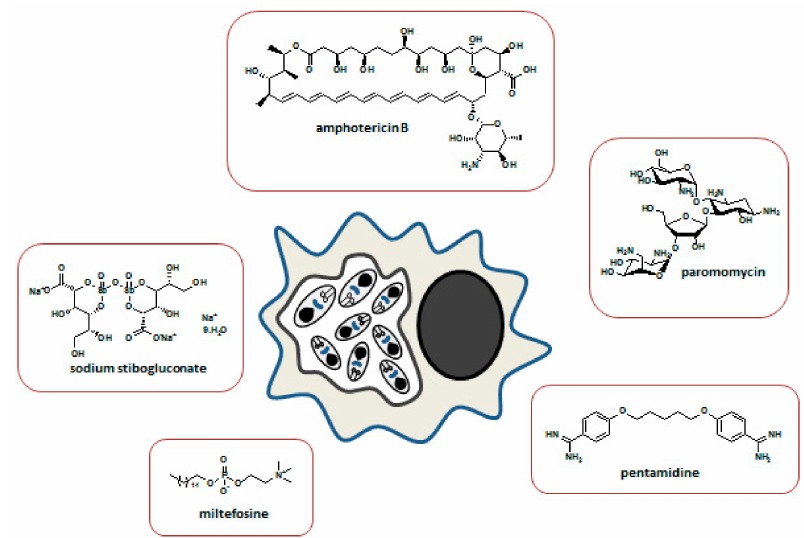
Figure 2. Intracellular amastigote form of leishmania parasite as the appropriate target for major antileishmanial drugs. Major drugs used in the treatment of leishmaniasis and their chemical